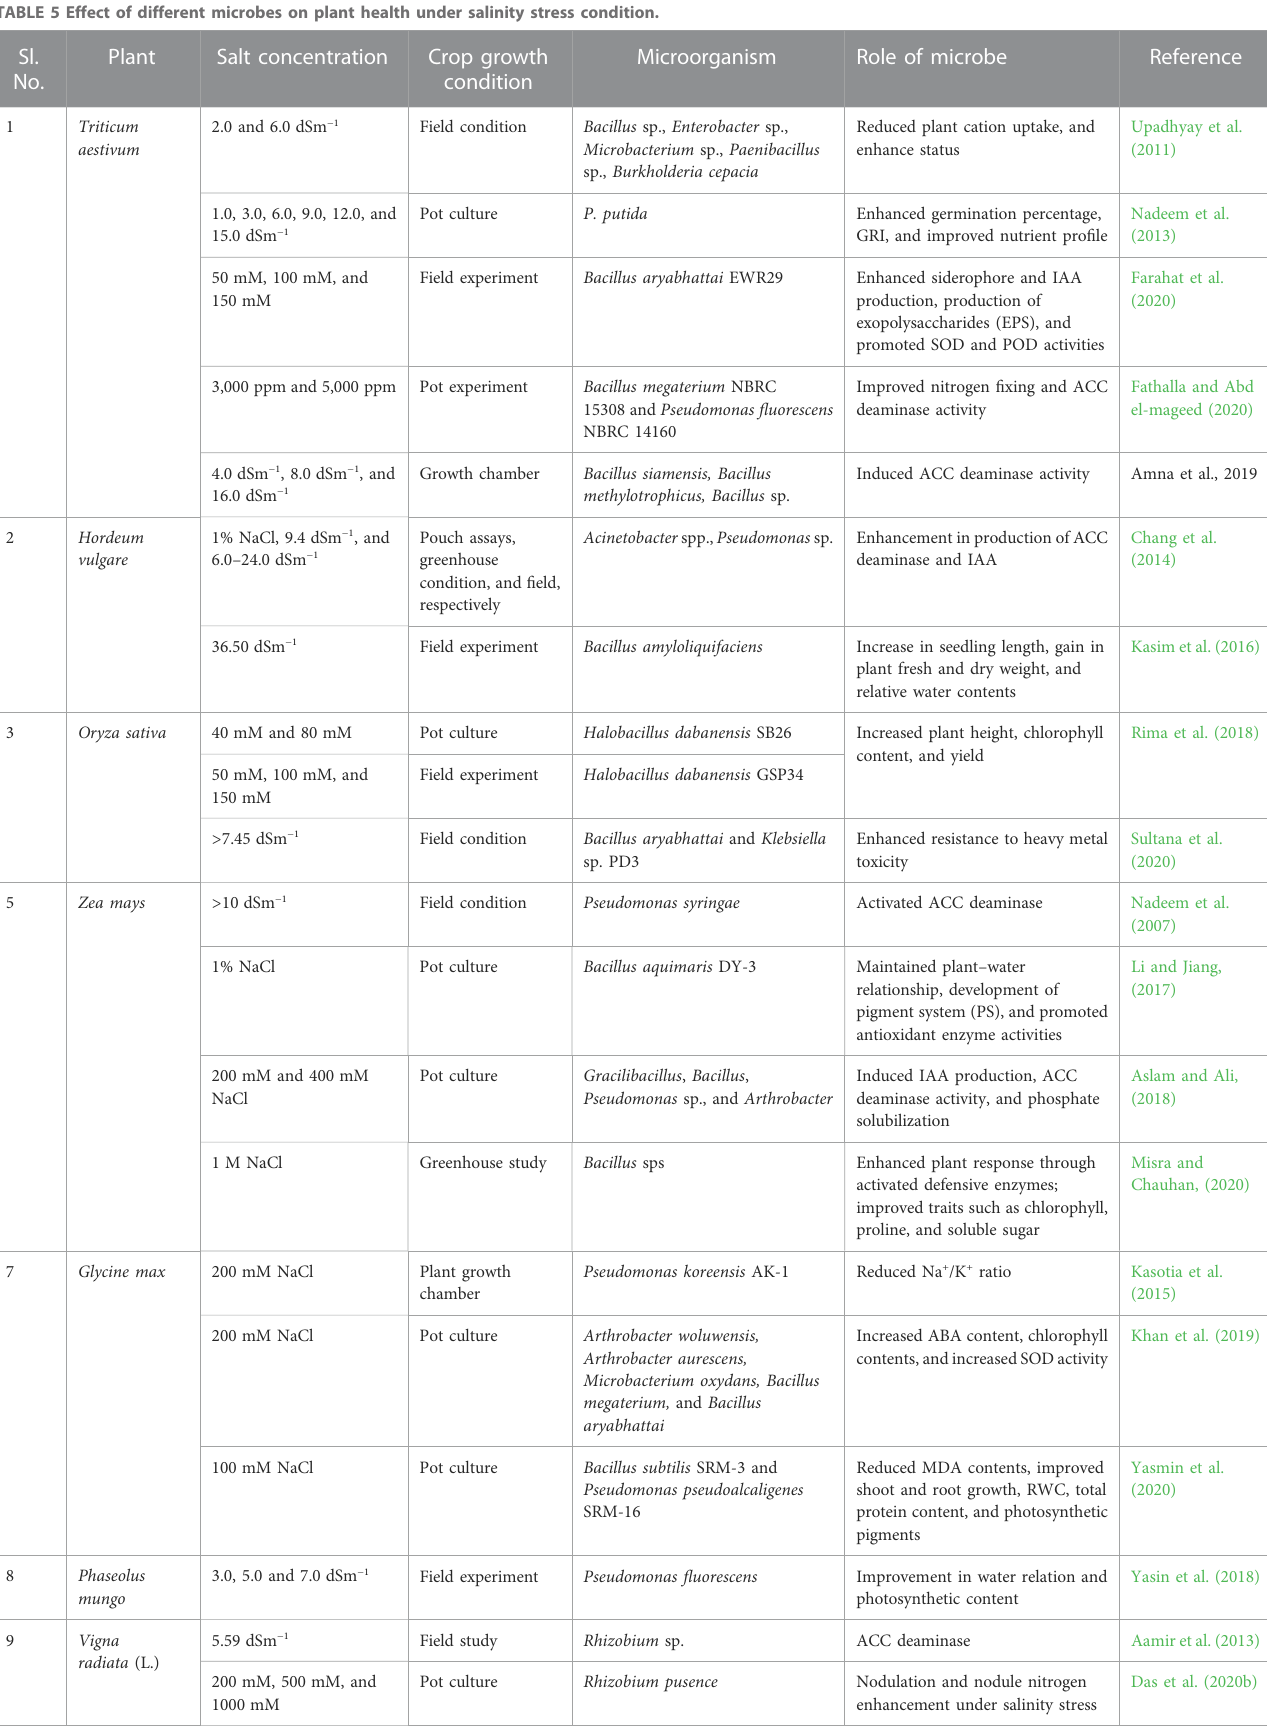
TABLE 5 Effect of different microbes on plant health under salinity stress condition. Sl.